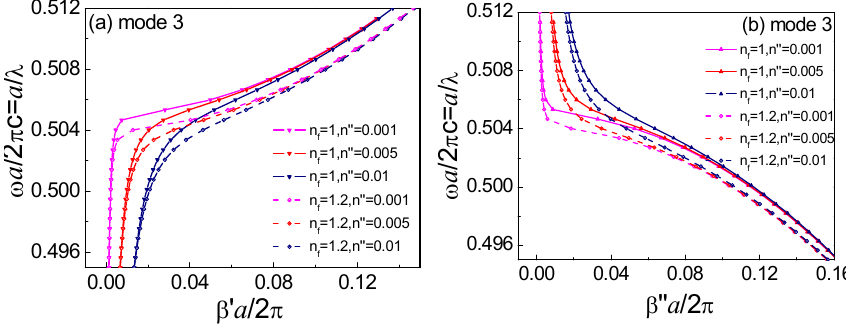
Figure 4. Complex propagation constants versus the normalized frequency α / λ for mode 3 of the un-infiltrated and infiltrated HC-PBF of Figure 1, ( a ) β’ , and ( b ) β ’’. Optical fluids ( 𝑛 (cid:2916) = 1.0,1.2 ) are infiltrated into the selected air holes (Figure 1). Other un-infiltrated air holes and the core are filled with gas, with a complex refractive index of 𝑛 = 𝑛 (cid:4593) + 𝑛 (cid:4593)(cid:4593) = 1 + 𝑛 (cid:4593)(cid:4593) and 𝑛 (cid:4593)(cid:4593) = 0.001, 0.005, 0.01.